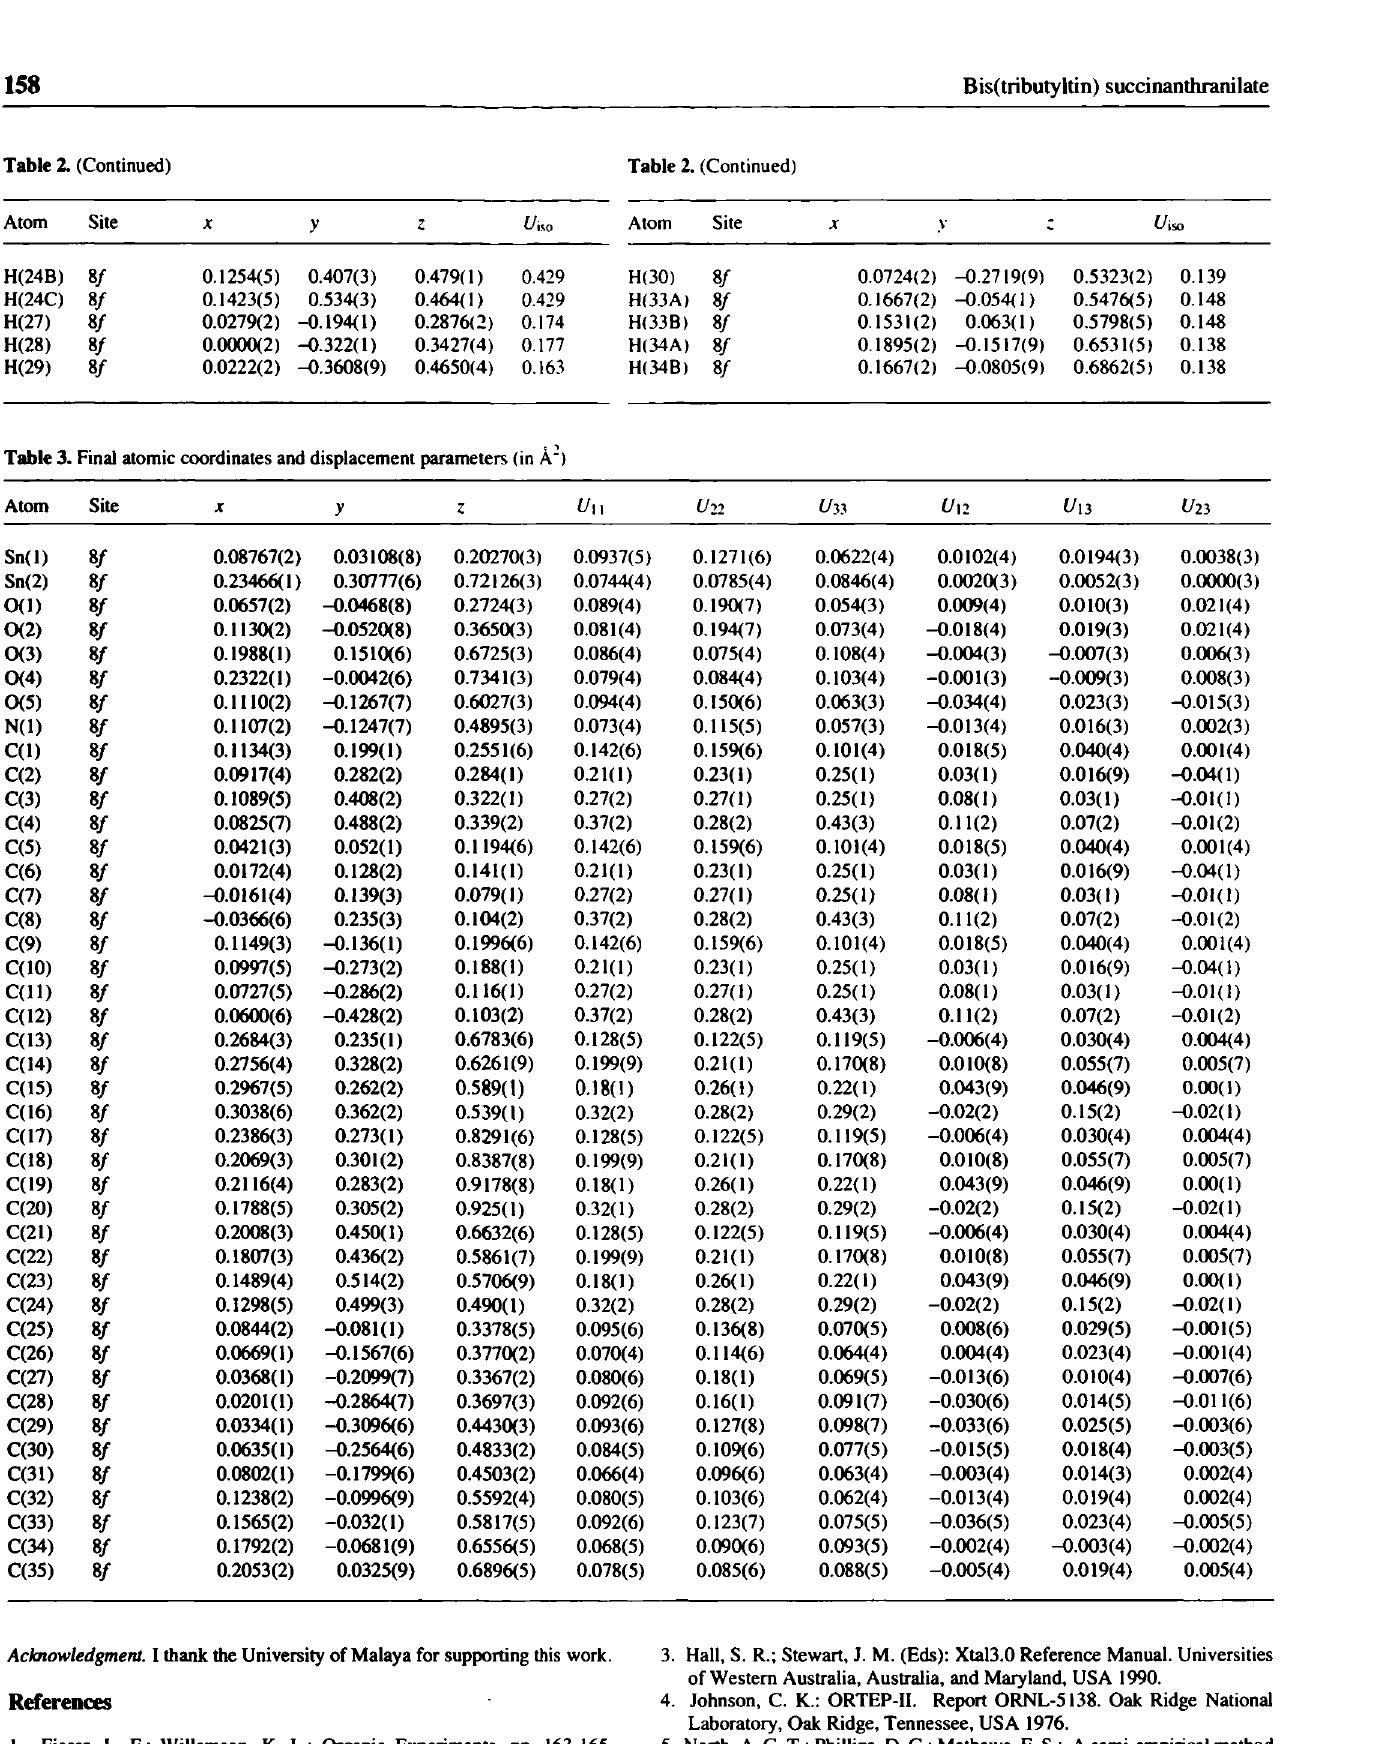
Table 3. Final atomic coordinates and displacement parameters (in